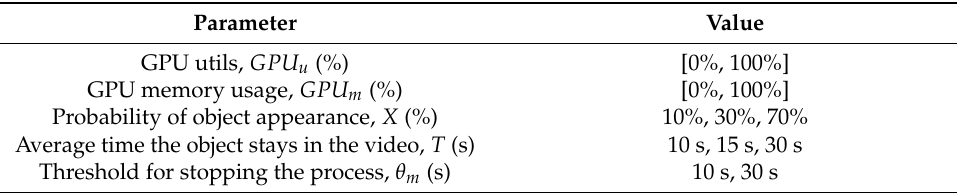
Figure 6. Video information. Table 2. System configuration and